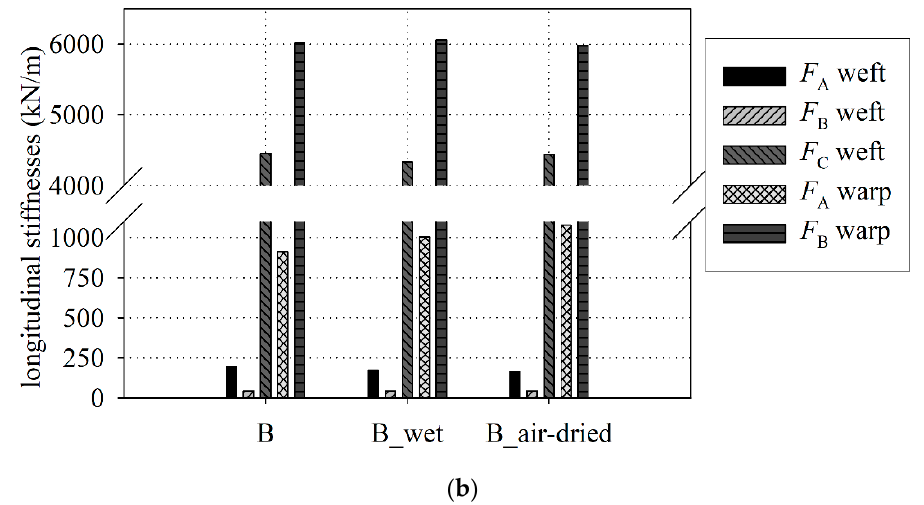
Figure 8. Longitudinal stiffnesses: ( a ) S type fabric; ( b ) B type fabric.